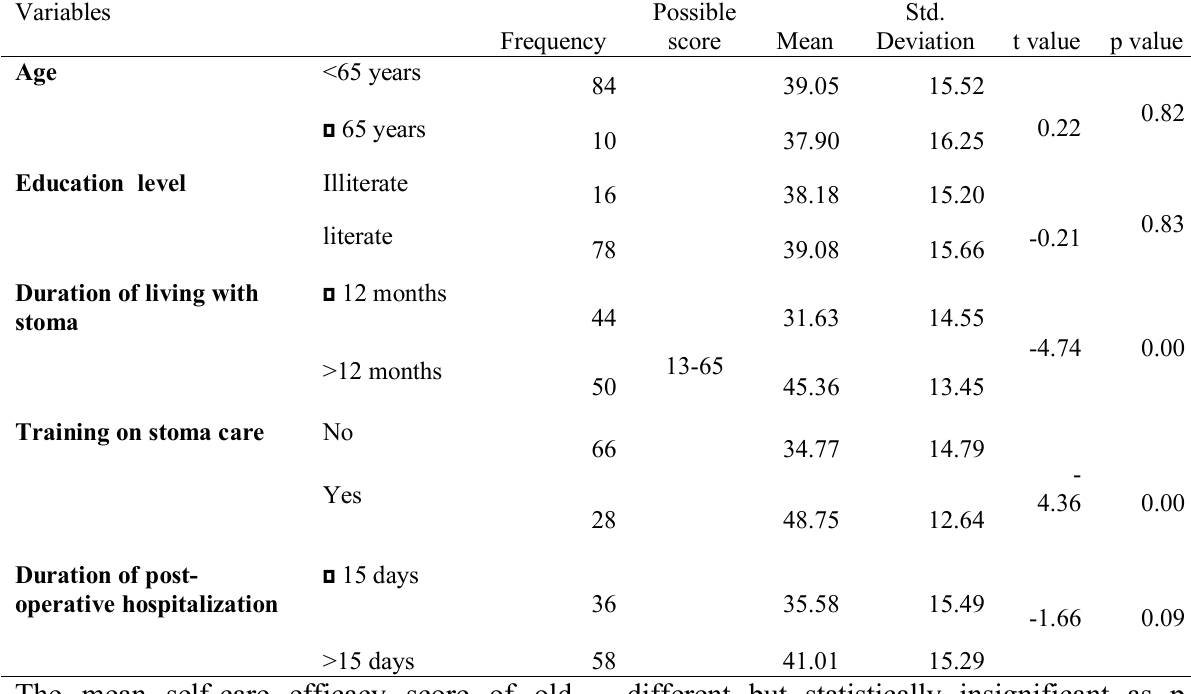
Table 11: Comparison of mean Self Care Efficacy with Variables N=94 Variables